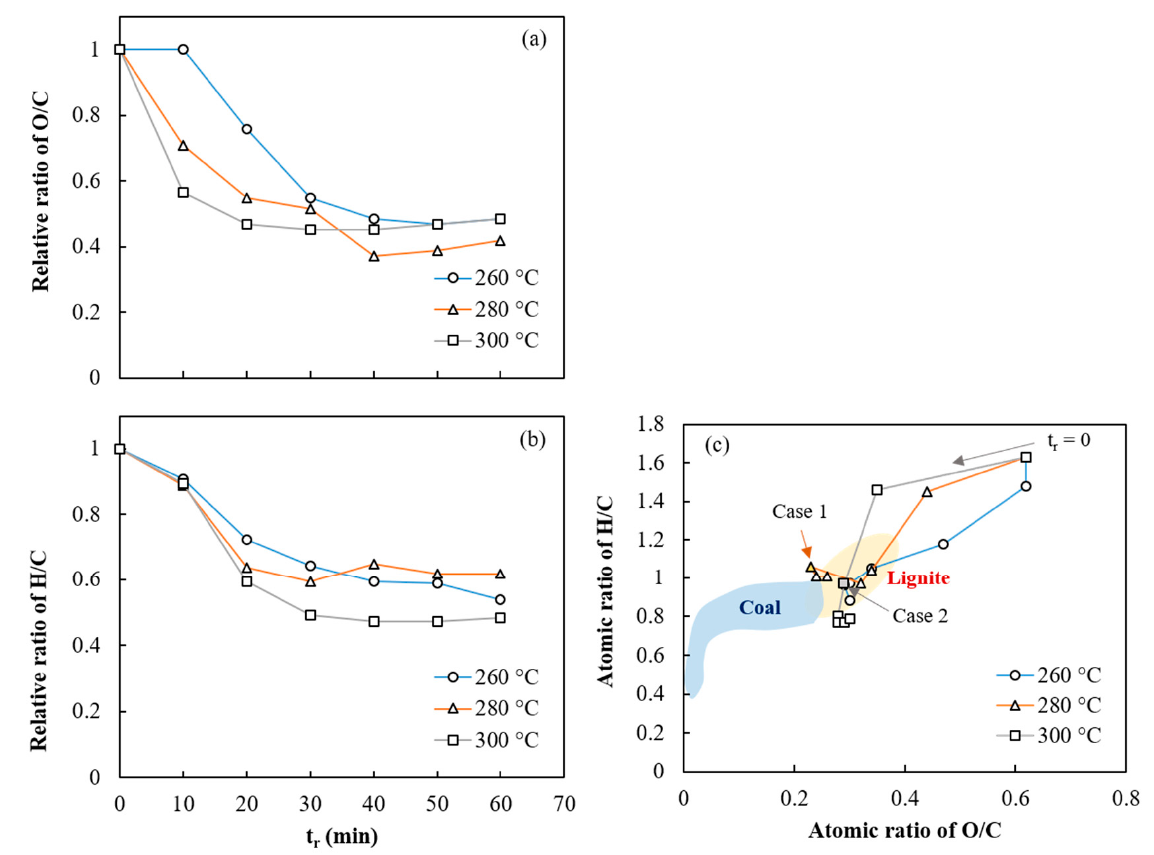
Figure 5. Relative ratio analyses of ( a ) O/C and ( b ) H/C as the atomic ratio of JMS T to that of raw JMS and ( c ) van Krevelen diagram (H/C vs. O/C) in various torrefaction conditions. Note: Case 1: E D of 1.37 at logSF = 6.90, T r = 280 °C and t r = 40 min; Case 2: E D of 1.35 at logSF = 7.19, T r = 300 °C and t r = 20 min.